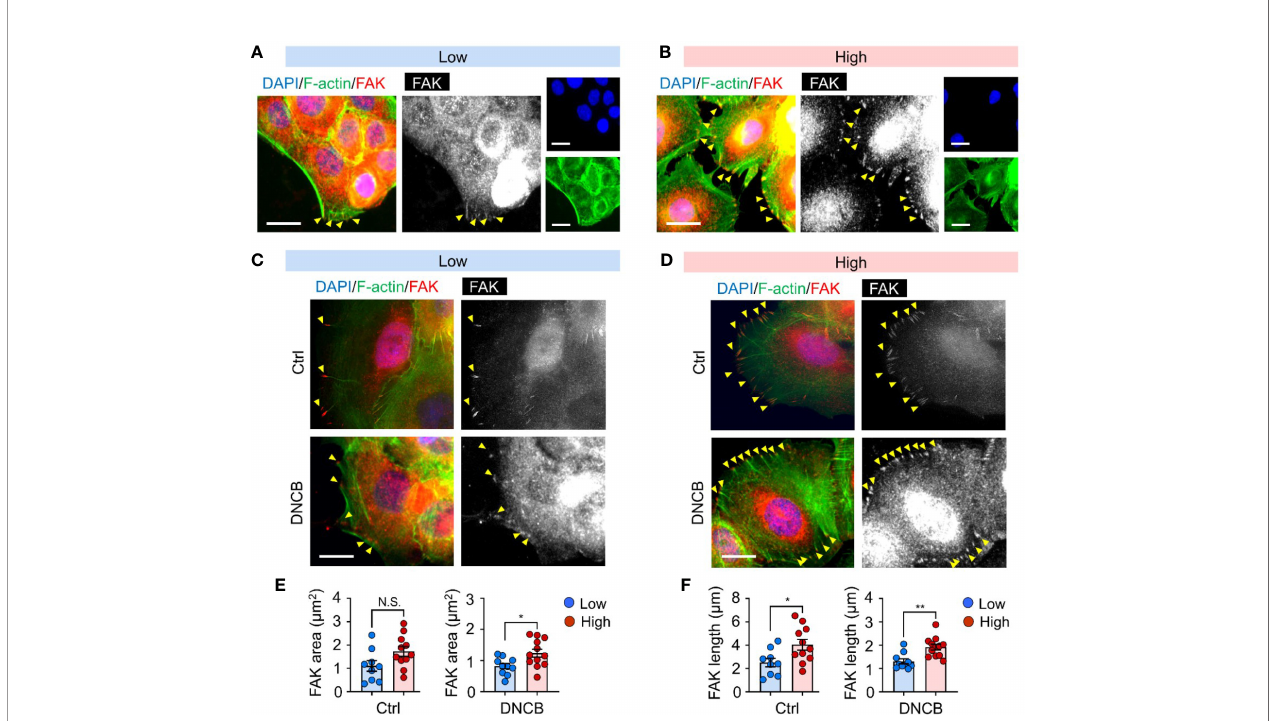
FIGURE 3 | Mechanical and chemical stimuli are coupled to coordinate FAK activation. (A, B) Representative immuno fl uorescent images showing the nucleus (DAPI, blue), F-actin (green), and focal adhesion kinase (FAK, red) in HaCaT cells cultured on substrates with low (20 kPa) (A) and high (1200 kPa) stiffness (B) . Yellow arrowheads indicate FAK at the cell periphery. (C, D) Representative immuno fl uorescent images showing the nucleus (blue), F-actin (green), and FAK (red) in HaCaT cells on substrates with low (C) and high (D) stiffness in response to 0.1% DMSO (Ctrl) and DNCB. Scale bar = 25 m m. (E, F) Quanti fi cation of area (E) and length (F) of FAK estimated from fl uorescent images in (C, D) . n = 9~12/group. Data represent the mean ± S.E.M. * p < 0.1; ** p < 0.01 by Student ’ s t -test. N.S., nonsigni fi